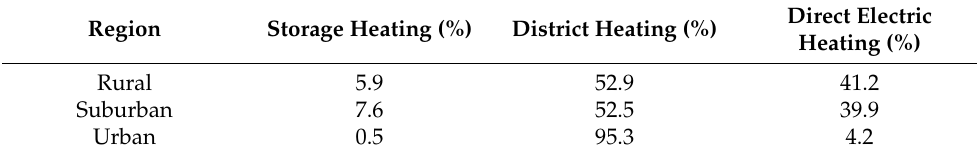
Table 3. The loading contribution of heating modes in three Finnish regions.